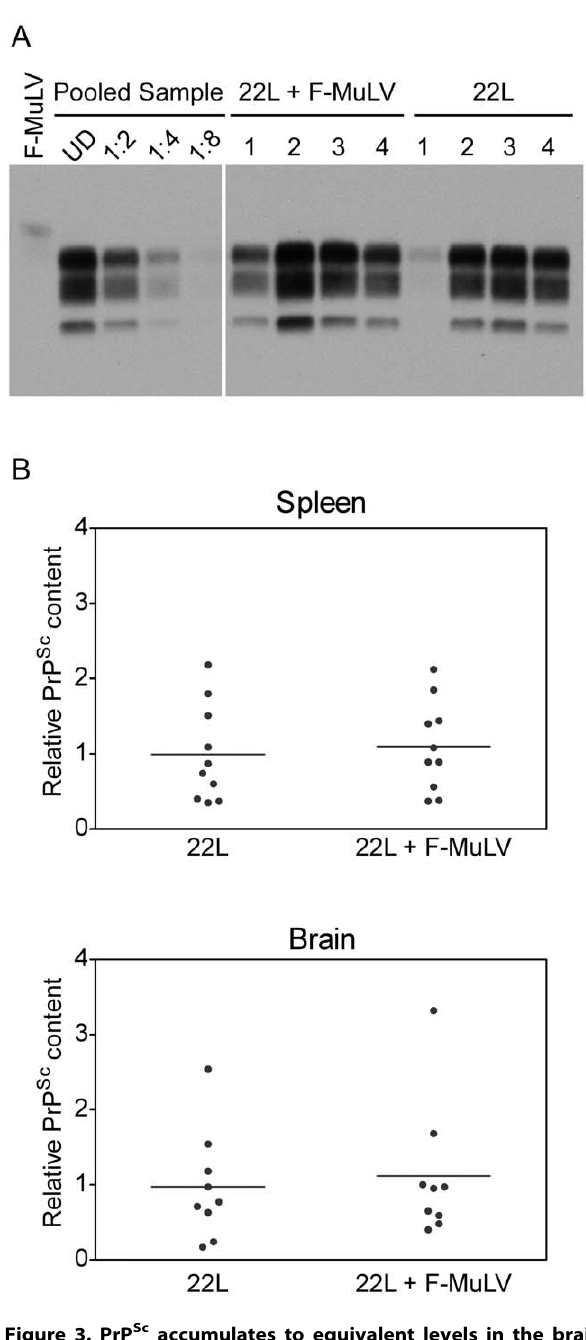
Figure 3. PrP Sc accumulates to equivalent levels in the brain and spleen of mice infected with 22L or 22L plus F-MuLV. (A) Western blot of PK-treated spleen homogenates from (B10 X A.BY)F1 mice either inoculated i.v. with FV alone (F-MuLV), i.p. with mouse 22L mouse scrapie alone (22L), or co-infected with 22L mouse scrapie i.p. and FV i.v. (22L + F-MuLV). Samples from 4 individual mice are shown for both 22L and 22L + FV and a single sample for FV infected mice. Lanes 2– 5 show dilutions of a standard comprised of equal amounts of spleen homogenate from individual mice inoculated with 22L + FV (Pooled Sample) used to calculate the relative amount of PrP Sc in the spleen of infected mice. (B) The relative amount of PrP Sc in each lane in (A) was determined by quantitative comparison to a standard curve derived from equal amounts of spleen homogenate (as shown in panel A) or brain homogenate (data not shown) derived from individual mice inoculated with 22L + FV.